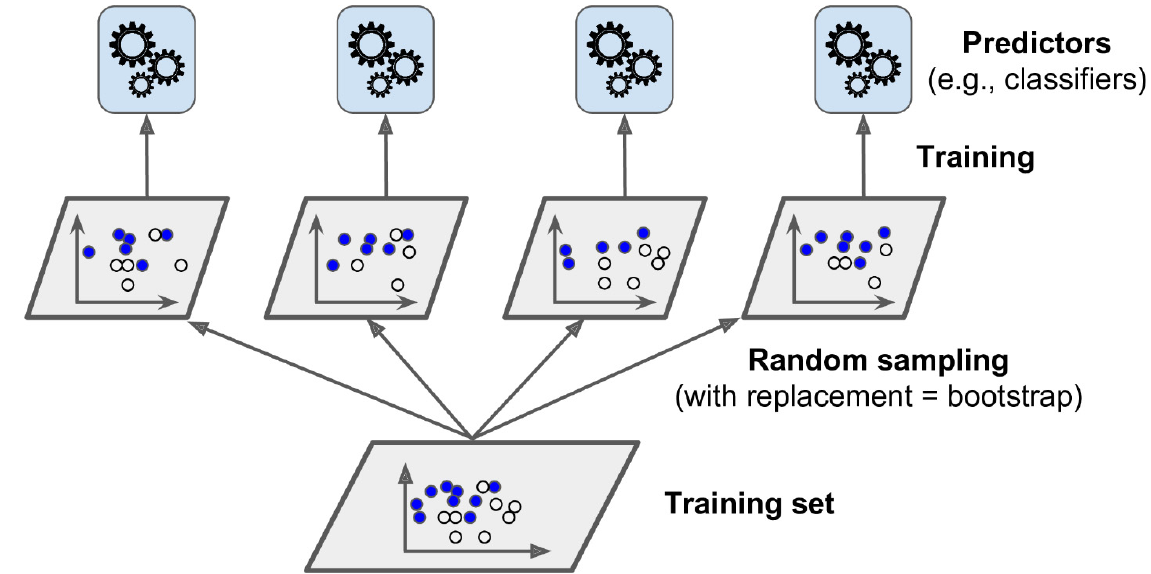
Figure 2. Bagging of the training set [21].